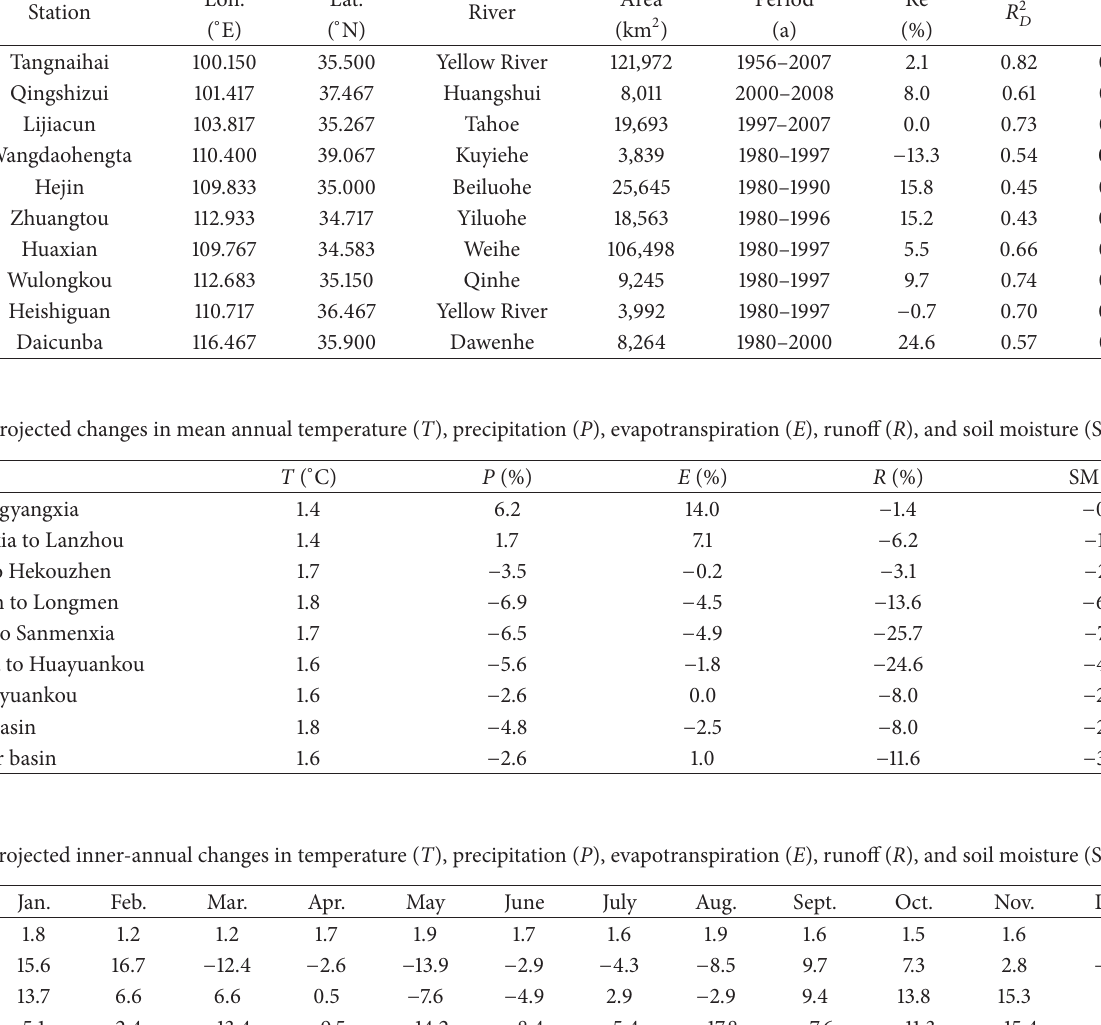
Table 3: Calibration results of the VIC model in the 10 subbasins of the YRB. Station